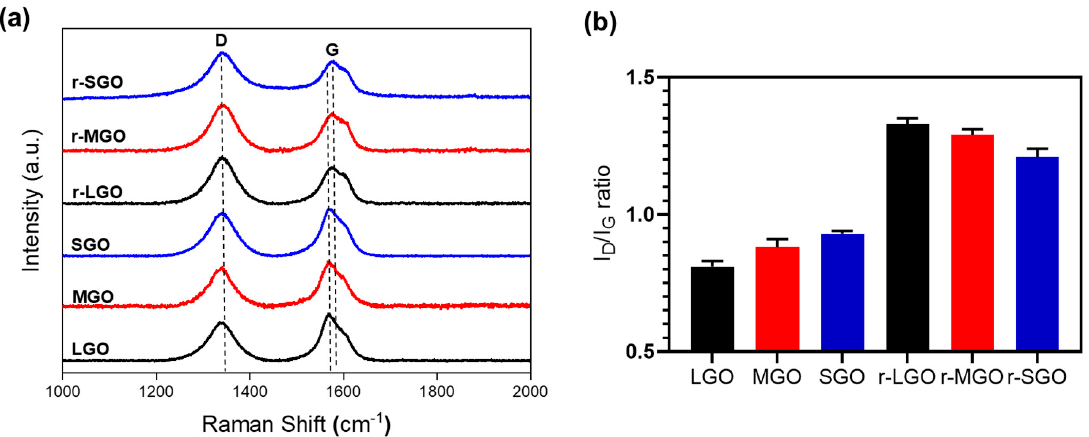
Figure 2. Raman spectroscopy of three GO and rGO colloidal samples. ( a ) Normalized general Raman spectra of different-sized GO and corresponding rGO. ( b ) I D /I G ratios based on the Raman intensity of D band and G band. Error bars represent standard error of mean (SEM), n = 3.